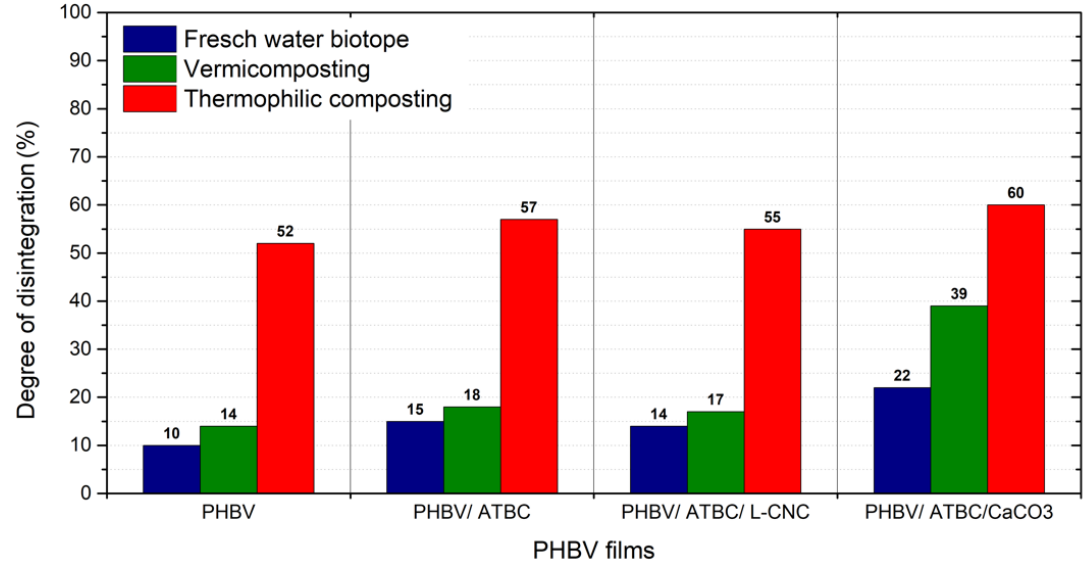
Figure 2. Degree of disintegration of PHBV bio-composites after 30 days’ degradation.